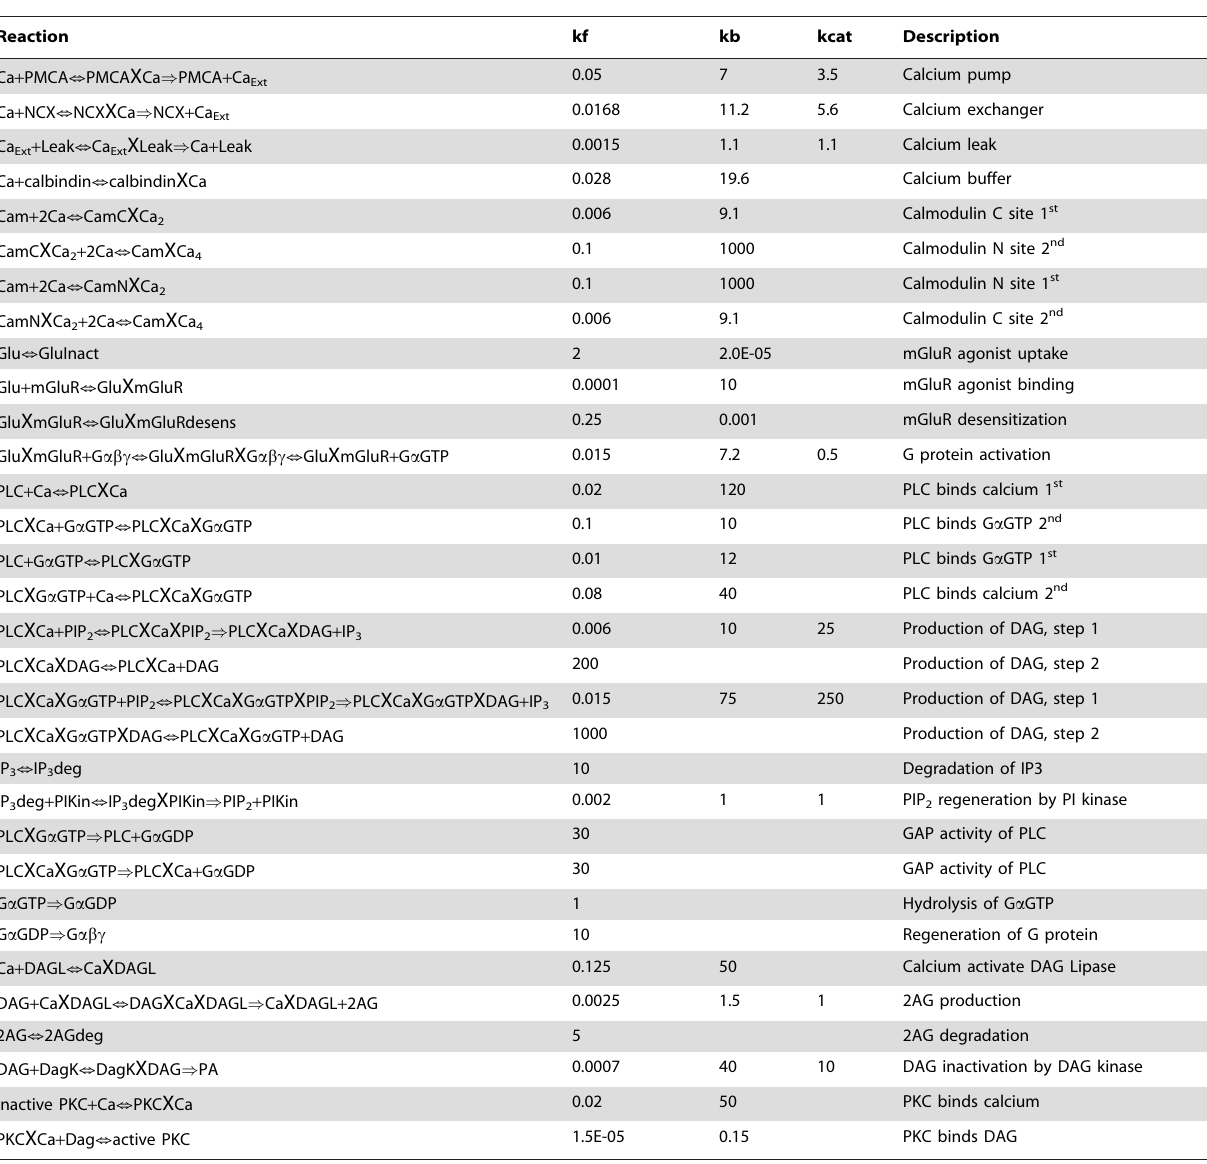
Table 1. Reactions and rate constants of signaling pathways in the model.